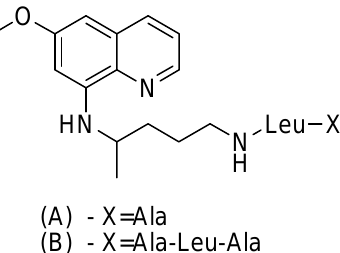
Figure 21. Chemical structures of (A) alanylleucylprimaquine and (B)